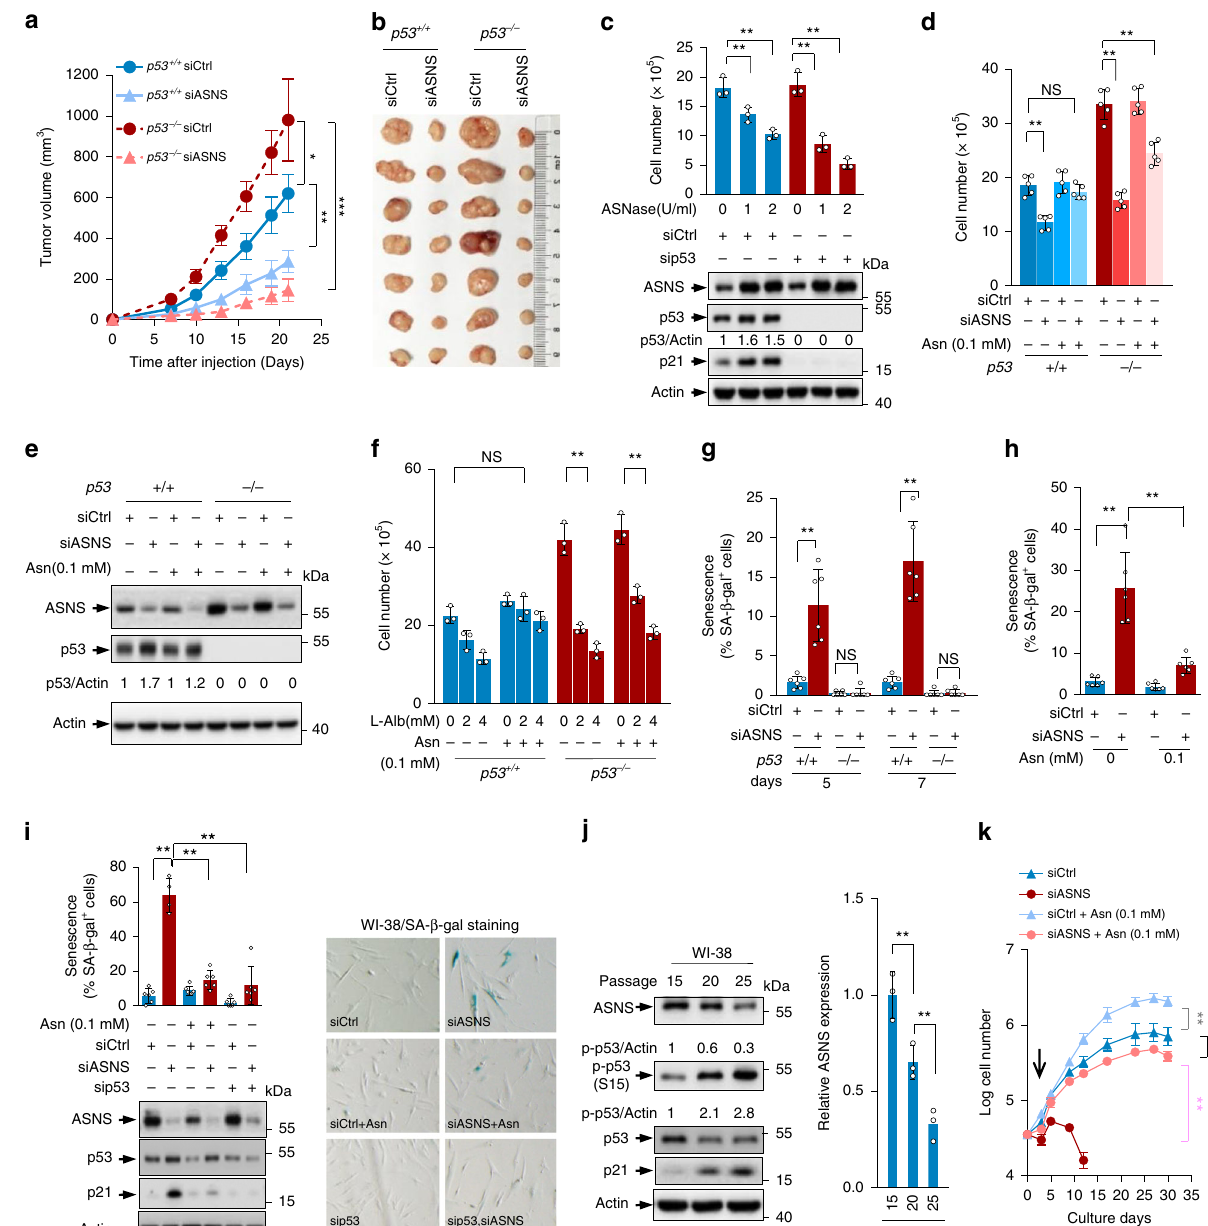
Fig. 3 ASNS modulates cell proliferation and senescence via asparagine. a , b p53 + / + and p53 − / − HCT116 cells expressing control or ASNS siRNA were injected subcutaneously into the dorsal fl anks of twenty-eight nude mice. Tumour volumes ( n = 7 mice in each group) were measured every 3 days after the tumours were visible ( a ). Representative images of xenografted tumours are shown ( b ). c HCT116 cells transfected with control or p53 siRNA were treated with increasing amounts of ASNase (0, 1 or 2 U per ml) for 48 h. Cell proliferation and protein expression were analysed. d , e p53 + / + and p53 − / − HCT116 cells transfected with control or ASNS siRNA were cultured with or without 0.1 mM Asn for 3 days. Proliferation ( d ) and protein expression ( e ) were measured. f Proliferation of p53 + / + and p53 − / − HCT116 cells treated with 0, 2 or 4 mM L -albizziine ( L -Alb) or 0.1 mM Asn as indicated for 48 h. g Percentages of senescence-associated β -galactosidase (SA- β -gal)-positive p53 + / + and p53 − / − HCT116 cells transfected with control or ASNS siRNA for 5 or 7 days. h HCT116 cells transfected with control or ASNS siRNA were cultured in medium with or without 0.1 mM Asn for 5 days. Percentages of SA- β - gal-positive cells are shown. i WI-38 cells transfected with control, ASNS siRNA and/or p53 siRNA were cultured for 3 days in the presence or absence of 0.1 mM Asn as indicated. Representative images, percentages of SA- β -gal-positive cells and protein expression are shown. j Protein expressions in WI-38 cells at different passages were measured. k The replicative lifespan of WI-38 cells treated with control, ASNS siRNA and/or 0.1 mM Asn as indicated. Arrow indicates the onset of senescence. Data are mean ± s.d., unpaired two-tailed Student ’ s t -test, * p < 0.05, ** p < 0.01, *** p < 0.001, NS not signi fi cant. Source data are provided as a Source Data fi